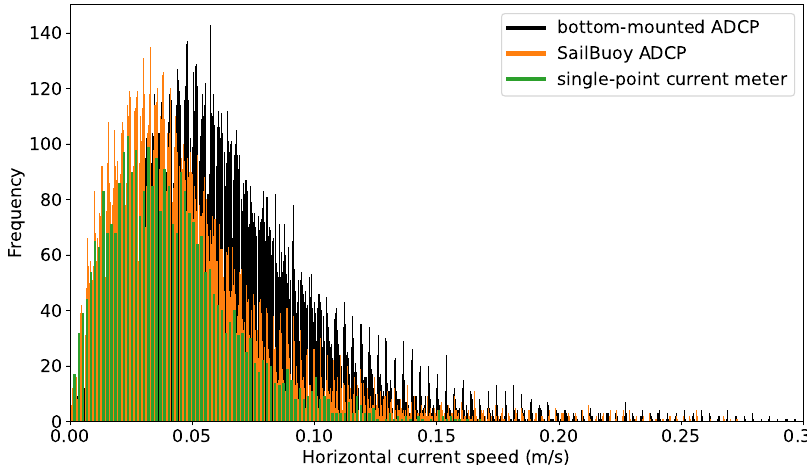
Figure 5. Histogram of the current speed data measured by the SailBuoy and bottom-mounted ADCPs and single-point current meter.